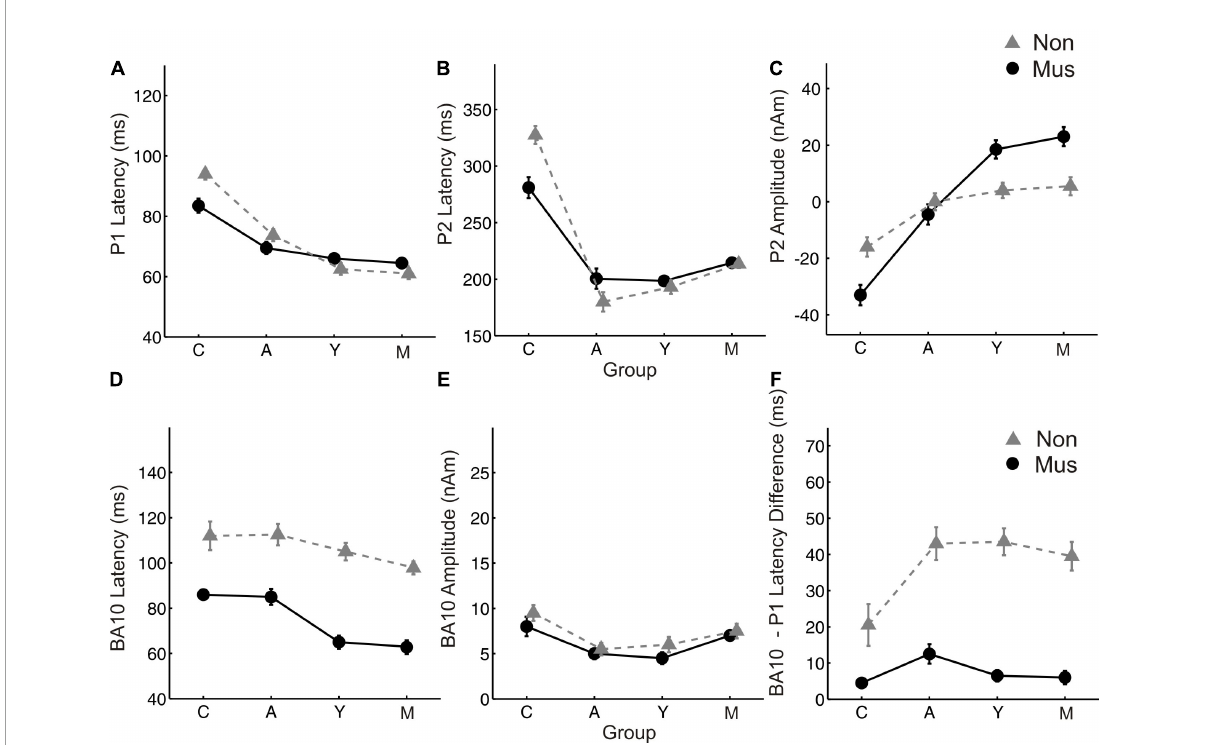
FIGURE4 Age related changes of the most important MEG variables. Group averaged values of (A) P1 latency (B) P2 latency (C) P2 amplitude (D) BA10 latency (E) BA10 amplitude (F) BA10-P1 latency difference, averaged over both hemispheres, respectively. Y-axis, latencies in ms and amplitudes in nAm. X-Axis, Subgroups of children (C), adolescents (A), young adults (Y), and middle-aged adults (O). Solid lines (circles), musicians; dashed lines (triangles),